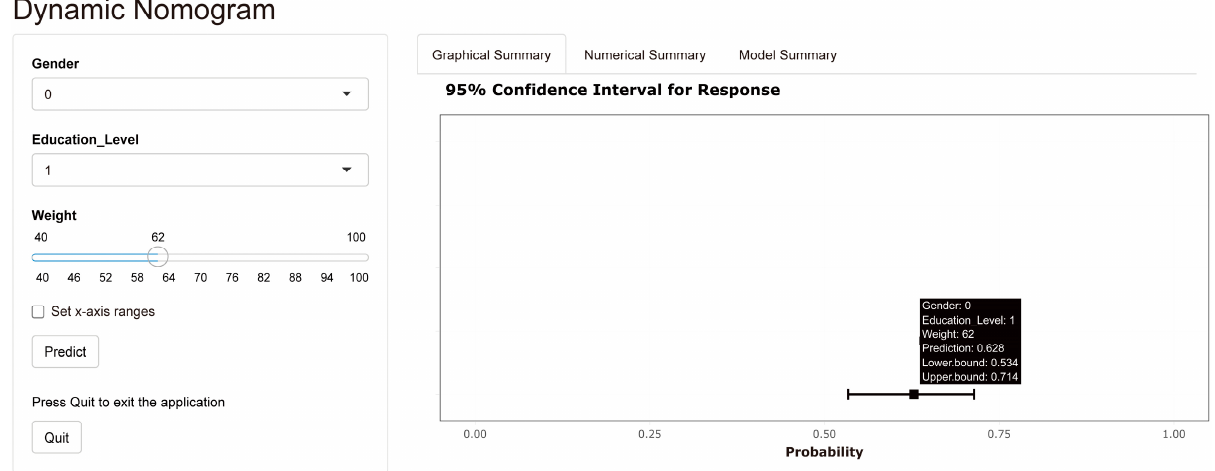
Figure 4. Dynamic Nomogram for predicting osteoporosis based on the training group. The Dynamic Nomogram can be used on computers and any mobile device. The specific link was: https://shibaolu.shinyapps.io/DynamicNomogram/ accessed on 22 December 2022. Here, the three specific clinical characteristics of the clinical subjects can be set via the parameter box on the left. When the “Predict” button was clicked, the predicted probability and 95% confidence interval for osteoporosis for this clinical subject can be displayed in the “Graphical Summary” box on the right. Here, a female clinical subject with an education level of 1 and a weight of 62 kg was still used as an example.” The “1”, “2”, and “3”